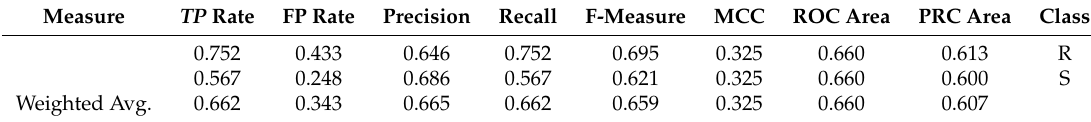
Table 3. Detailed accuracy by class of LIBSVM (10-fold cross-validation).